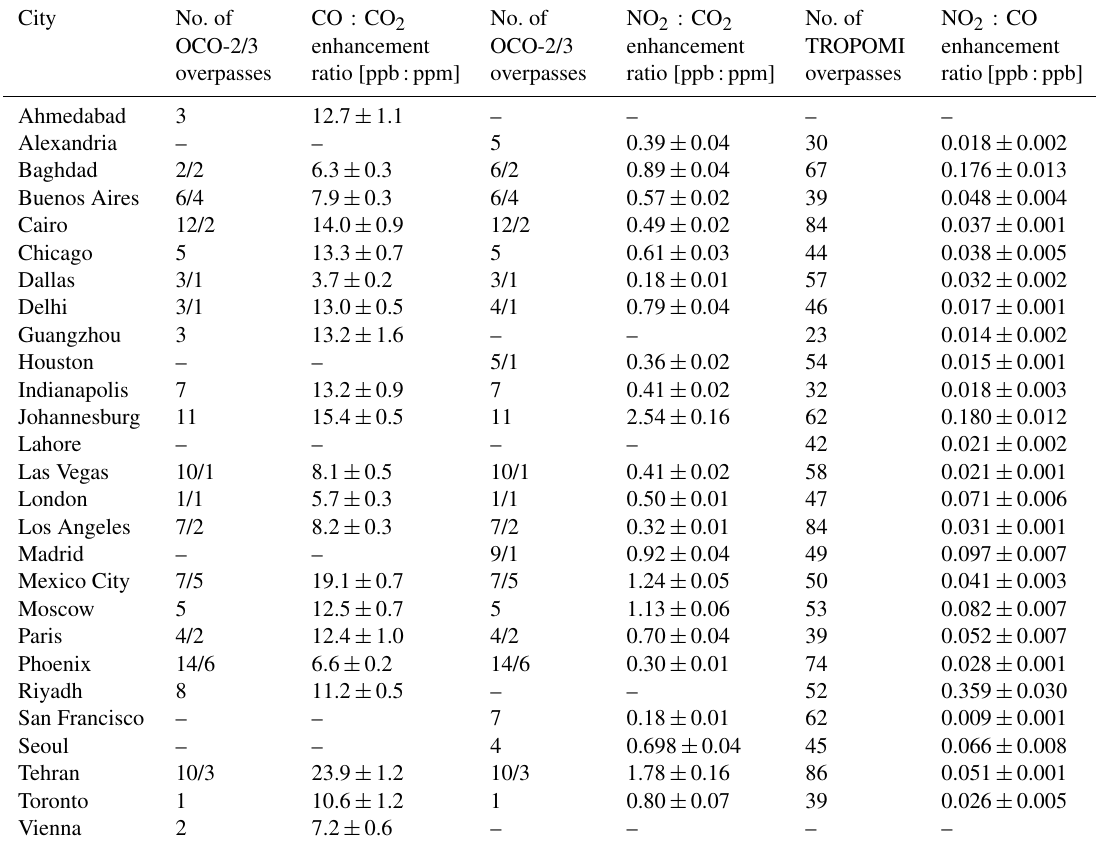
Table 2. All enhancement ratios derived using OCO-2/3 and TROPOMI. Overpasses must individually have sufficient linear dependence ( R > 0 . 2). Cities without any such overpasses are marked by a